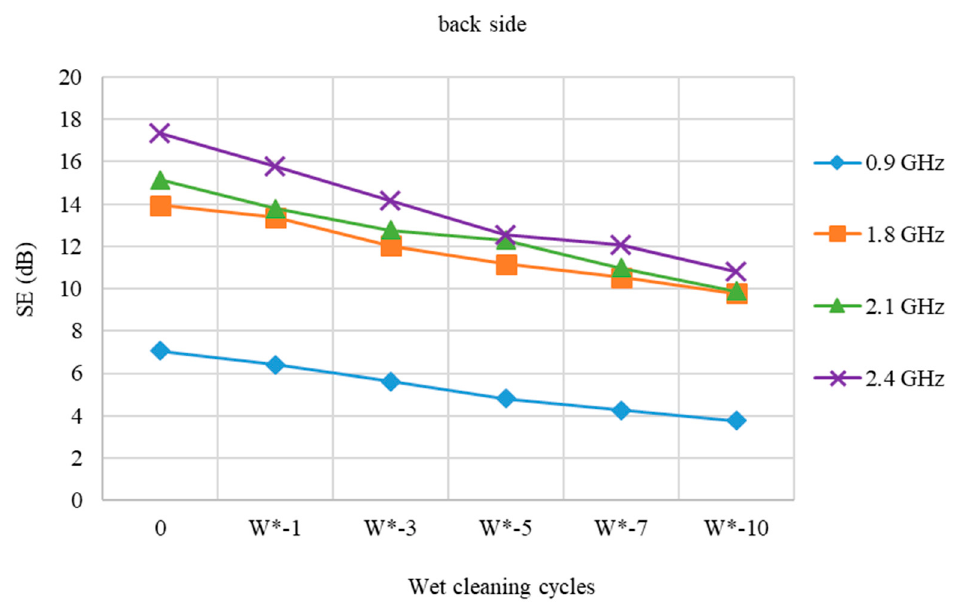
Figure 7. Shield effectiveness of PES/CO/SS fabric (back side) before and after 1st, 3rd, 5th, 7th, and 10th wet cleaning cycles (W*) at frequencies 0.9 GHz, 1.8 GHz, 2.1 GHz, and 2.4 GHz. The differences in SE findings between the face and back sides are still negligible. The decrease in SE at frequencies 0.9 and 2.4 GHz is less linear than at frequencies 1.8 and 2.1 GHz.